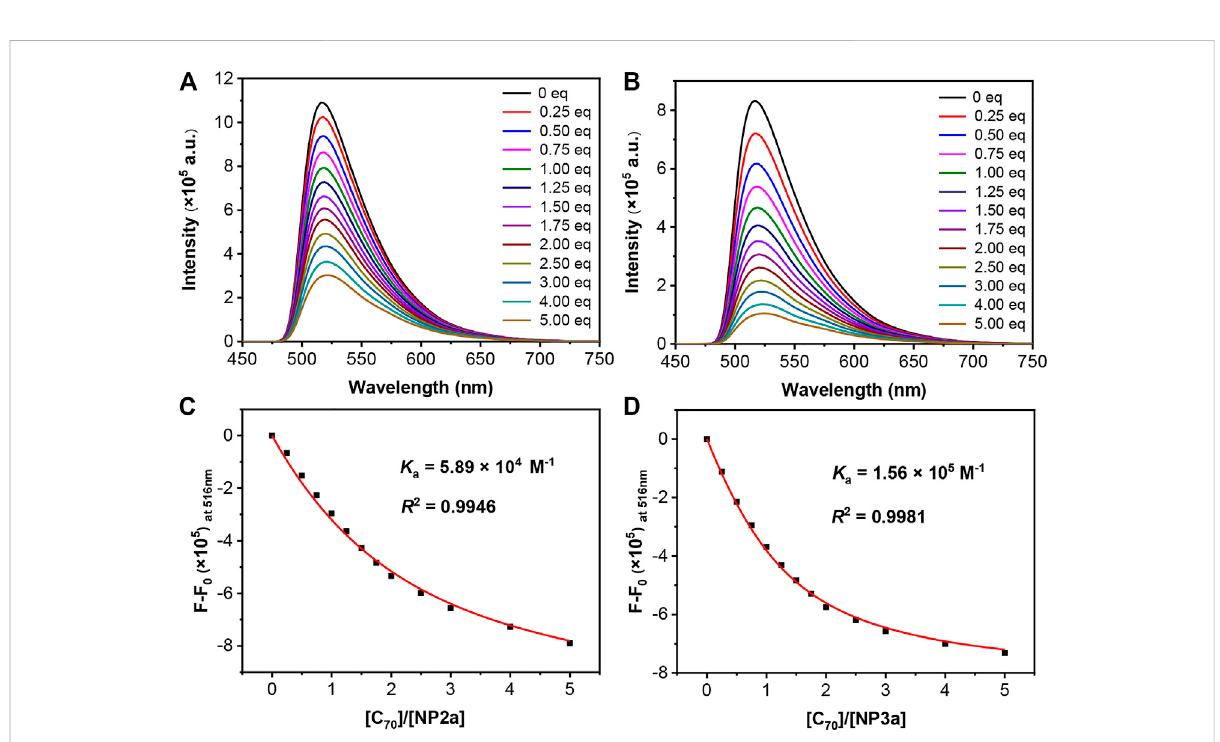
FIGURE 7 Fluorescence spectral change of (A) NP2a and (B) NP3a during titration with C 70 . Fitting curves on the relative fl uorescent intensity of (C) NP2a, (D) NP3a for obtaining K a , R 2 is the coef fi cient of